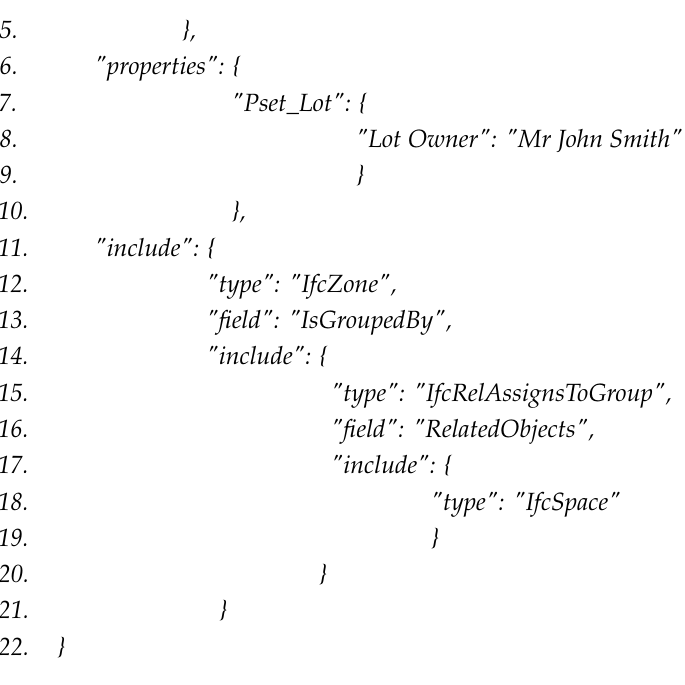
Figure 5. ( a ) The common property legal zone and ( b ) the legal zone for a private property. Figure 6 represents the building elements that define boundaries of a legal space (e.g., apartment unit 306). These include covering, window, slab, and walls. In Figure 6a, all the building elements that bound the legal space were retrieved using Query 4. However, it is also possible to retrieve only a specific type of building element, as presented in Query 5. Figure 6b–e represents an individual type of building elements (walls, window, covering and slab) for the legal space of apartment unit 306.